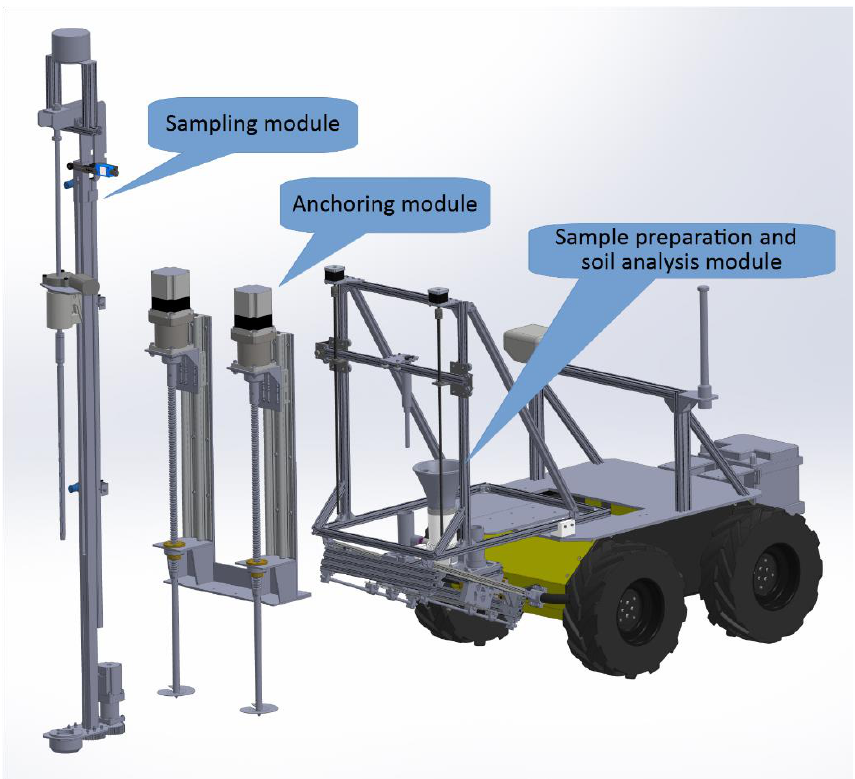
Figure 4. The 3D model of the exploded view of the agrobot Lala